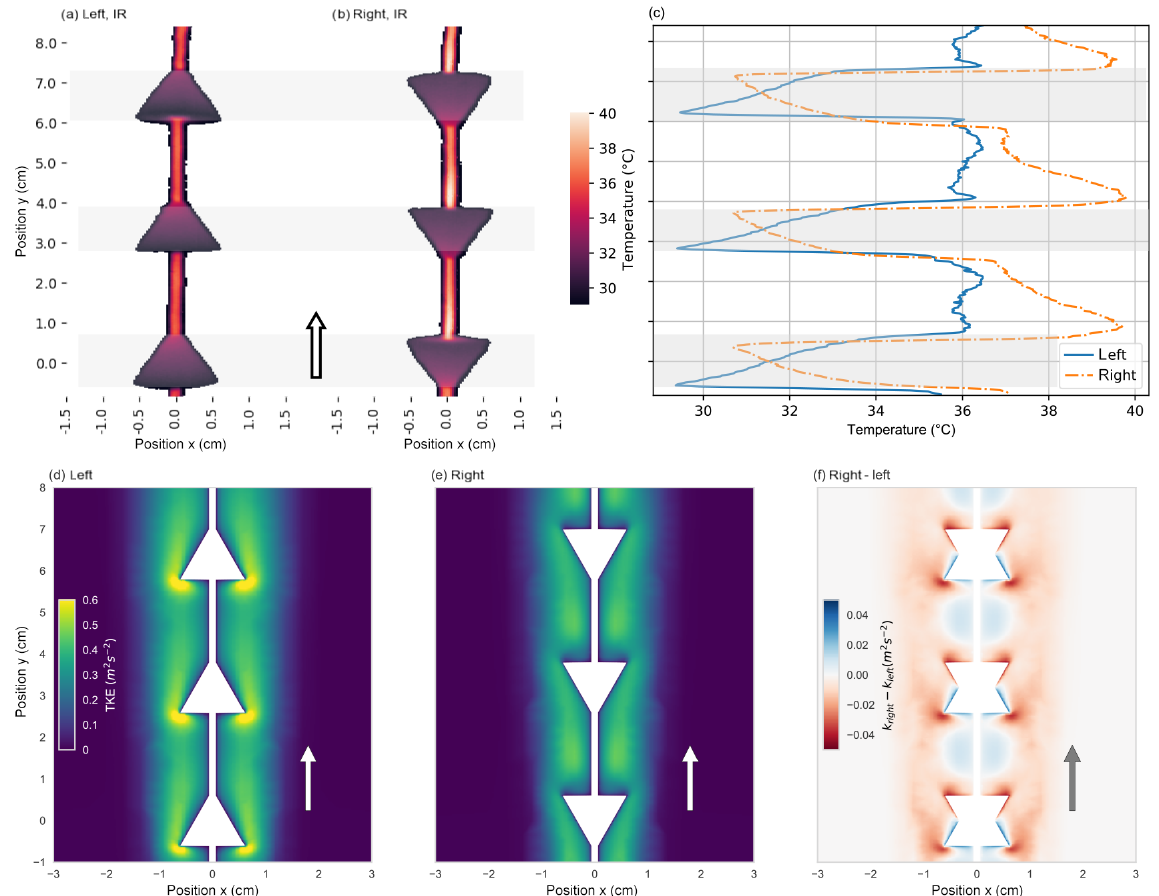
Figure 5. The brightness temperature of the fiber-optic cables with (a) left- and (b) right-pointing cones for the 12mm, 1 : 1 cones with 2cm spacing and a heating rate of 2.5Wm − 1 for a wind speed of 0.9ms − 1 . (c) The average of the three warmest pixels in each horizontal row is provided to better demonstrate the spatial pattern of temperatures along the fiber. The grey shading is to visually line up the cones in (a) – (c) . (d, e) Turbulence kinetic energy (TKE) computed from the CFD simulations for the same experiment as in (a) and (b) with (f) the difference in TKE between the two orientations. The difference in TKE was not physically meaningful in the region with a cone in either (d) or (e) and is excluded in (f) . The subset arrows indicate the direction of the mean